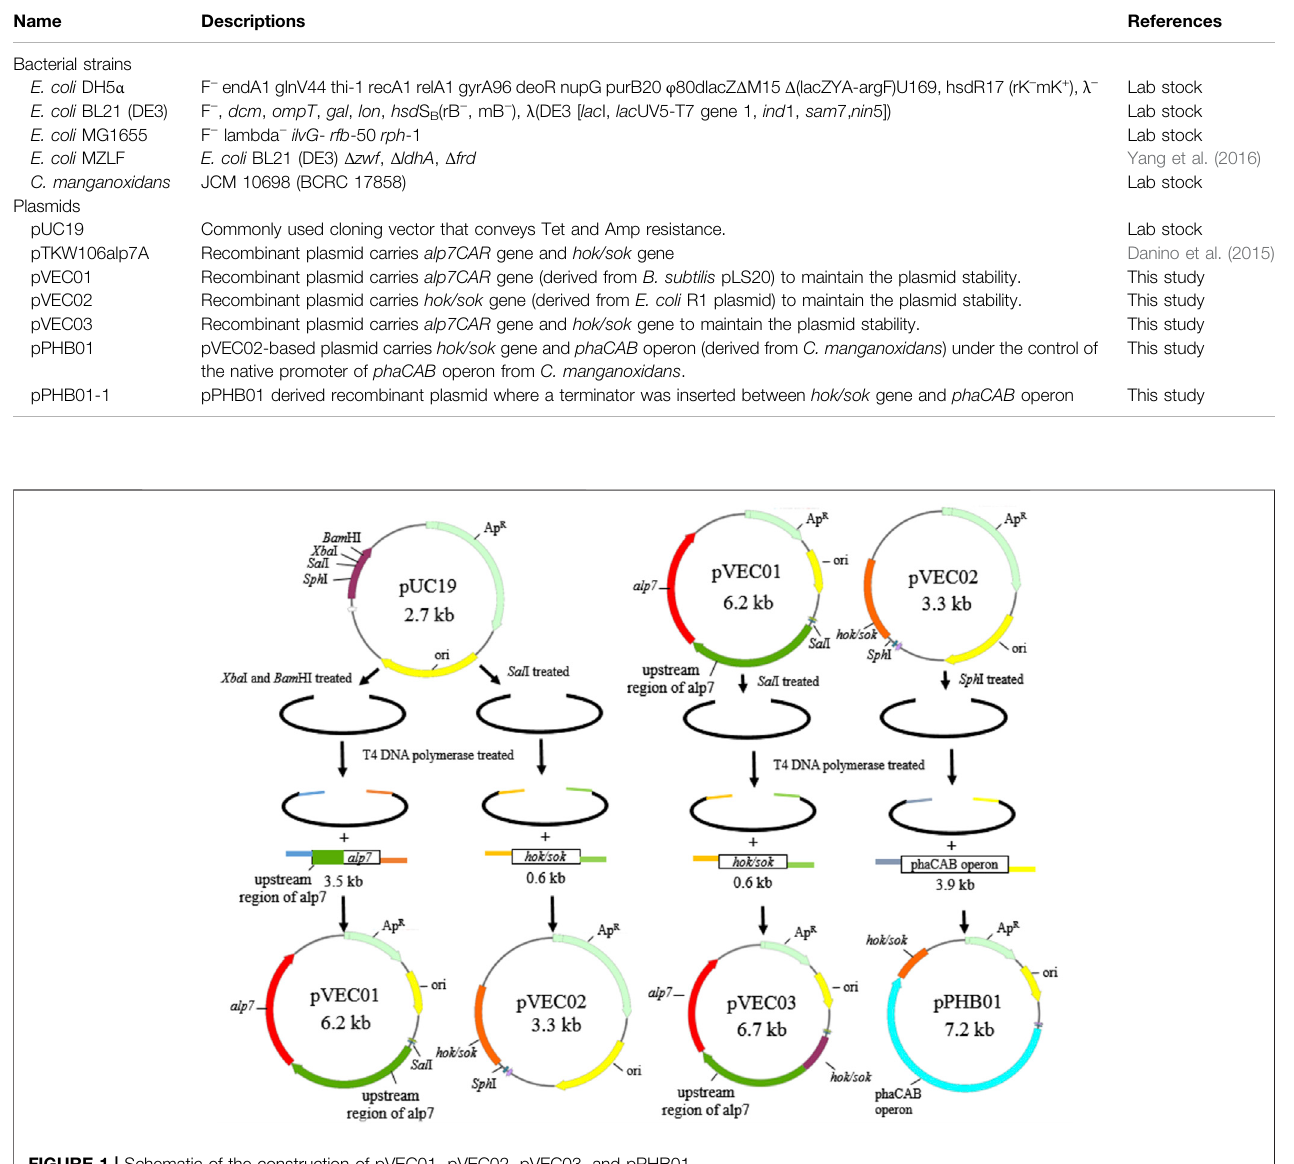
FIGURE 1 | Schematic of the construction of pVEC01, pVEC02, pVEC03, and